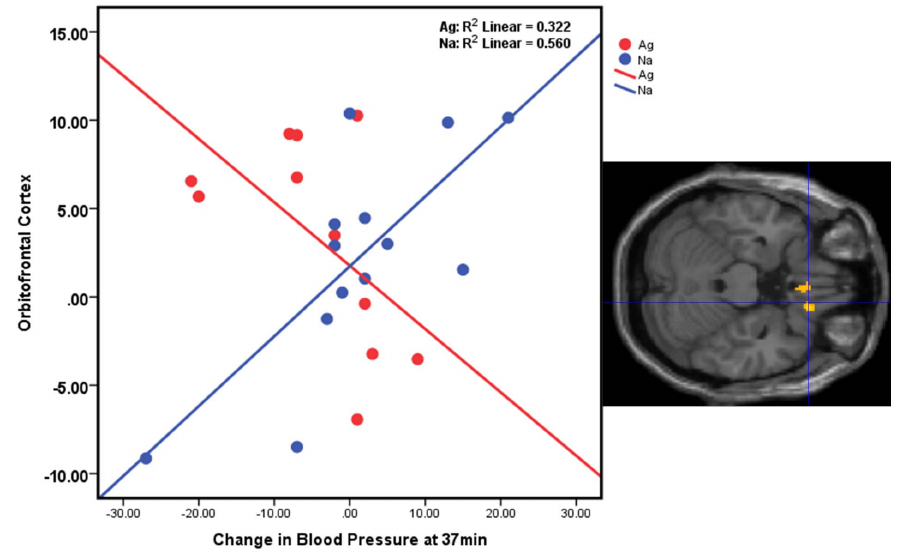
Figure 4. Coupling of blood pressure response with glucose metabolism in the OFC between the groups. On the y-axis is response in the OFC response to violent media compared with emotional media; on the x-axis is systolic BP change between violent media compared with emotional media at time 37 into the media viewing.